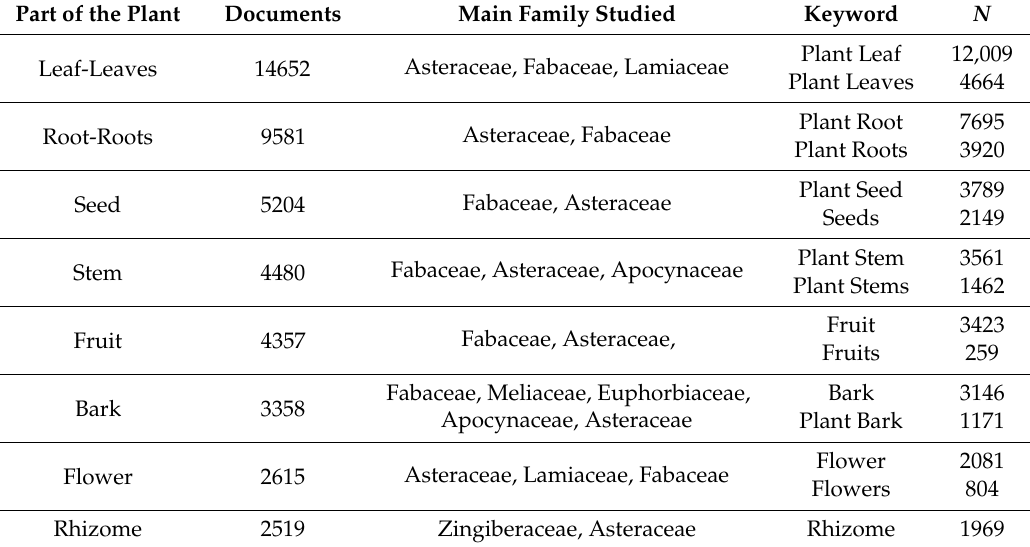
Table 4. Main keywords related to plant parts and plant families